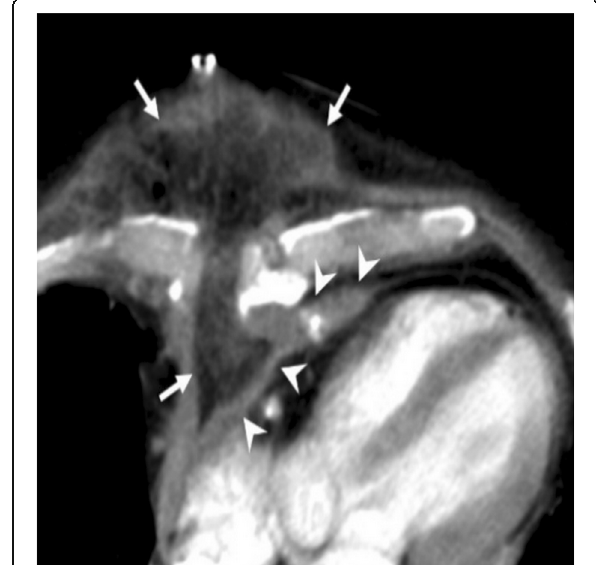
Fig. 26 A 65-year-old man with a previous history of surgery for constrictive pericarditis developed chronic sternal osteomyelitis on the follow-up period. Axial contrast-enhanced CT image demonstrates a pedicled fat flap (arrows) placed to maintain hemostasis and infection control. Pericardial thickening (arrowheads) is also noted